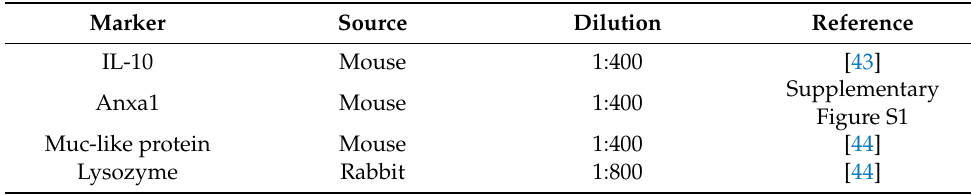
Table 1. List of first antibodies for indirect